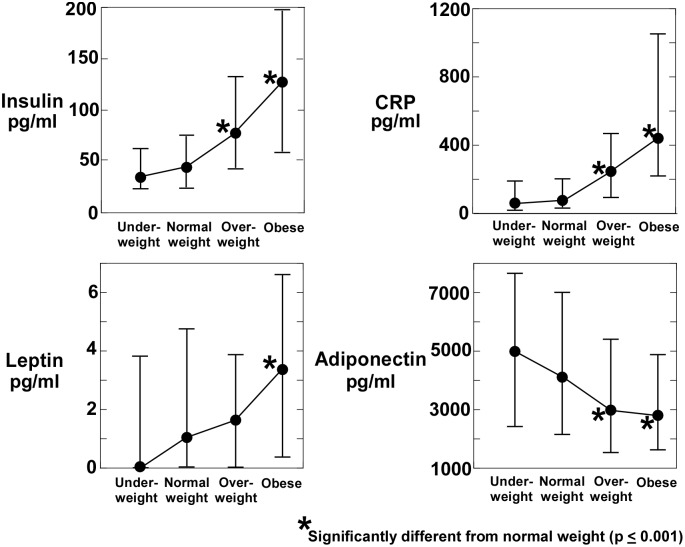
The concentration of biomarkers in saliva supernatant that were significantly different in obese children compared to normal weight children.Insulin, CRP and leptin significantly increased with obesity whereas adiponectin decreased. Central values represent the median concentration and whiskers represent the interquartile range (+75th percentile, −25th percentile).